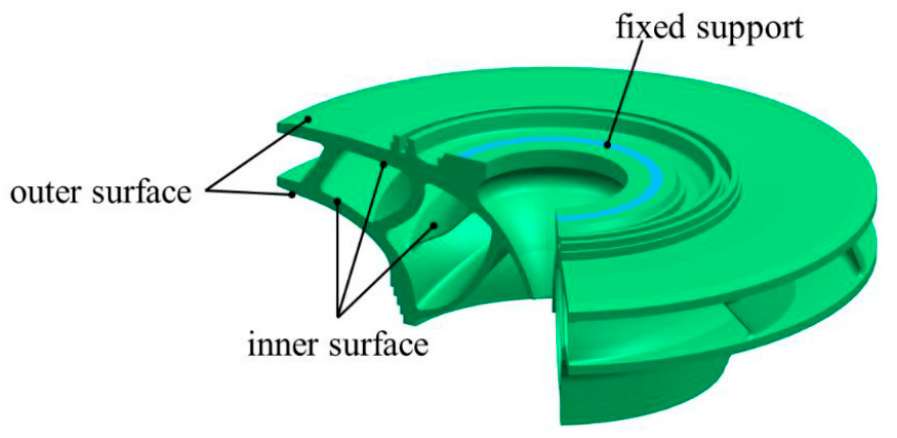
Figure 3. The fluid structure interaction (FSI) interface.